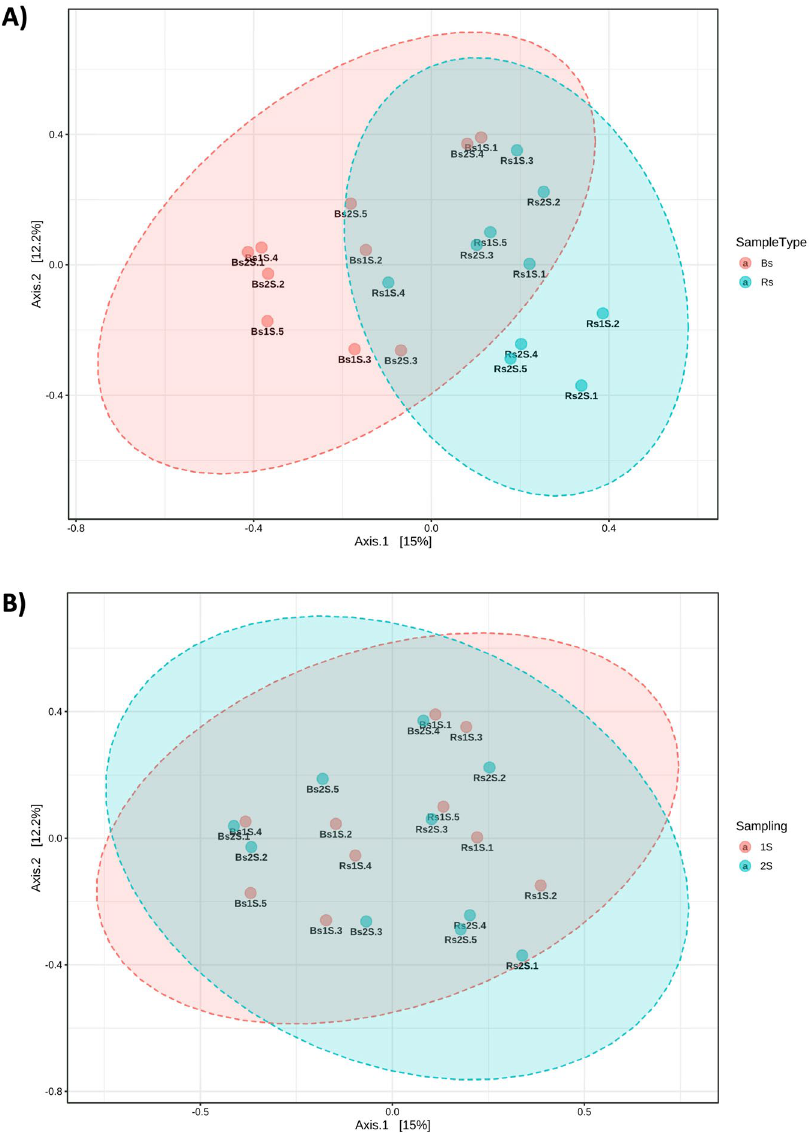
Figure 6. Principal Coordinates Analysis (PCoA). Comparison by PCoA of the ecological distance (with the Bray–Curtis distance based method) of the different compartments. (A) Soil type effect (Bs = Bulk soil, Rs = soil associated with the roots of V. vinifera cv. Pinot Noir), PERMANOVA F-value: 2.3313; R-squared: 0.11467; p-value < 0.001. (B) sampling time effect (1 S = flowering and 2 S = fruit development), PERMANOVA F-value: 0.75825; R-squared: 0.040422; p-value < 0.845. Beta diversity analysis was performed using the phyloseq package of MicrobiomeAnalyst, a free available on-line software